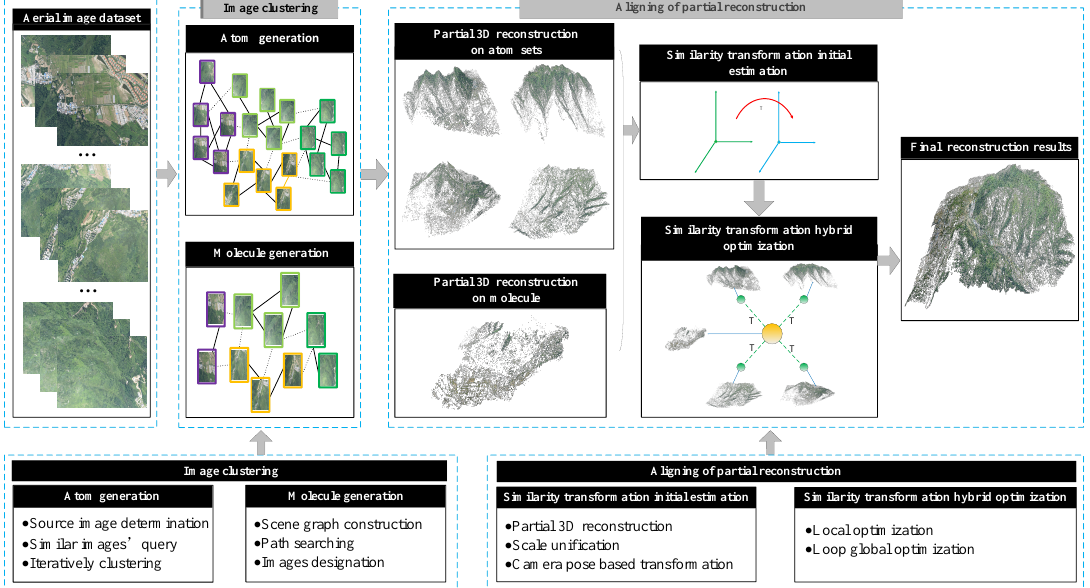
Figure 1. Framework of the proposed method, which contains two main parts: image clustering and the aligning of partial reconstructions. In the first part, we perform image clustering to get two image subsets, named atoms and molecules. Specifically, the images with the same color bounding box belong to the same atom. On the basis of image clustering, we utilize the image repetition relation between atoms and the corresponding molecule to align multiple partial reconstructions. In the aligning process, the similarity transformation is initially estimated by using the joint camera poses of common images and then optimized by our hybrid optimization method to realize a seamless fusion.